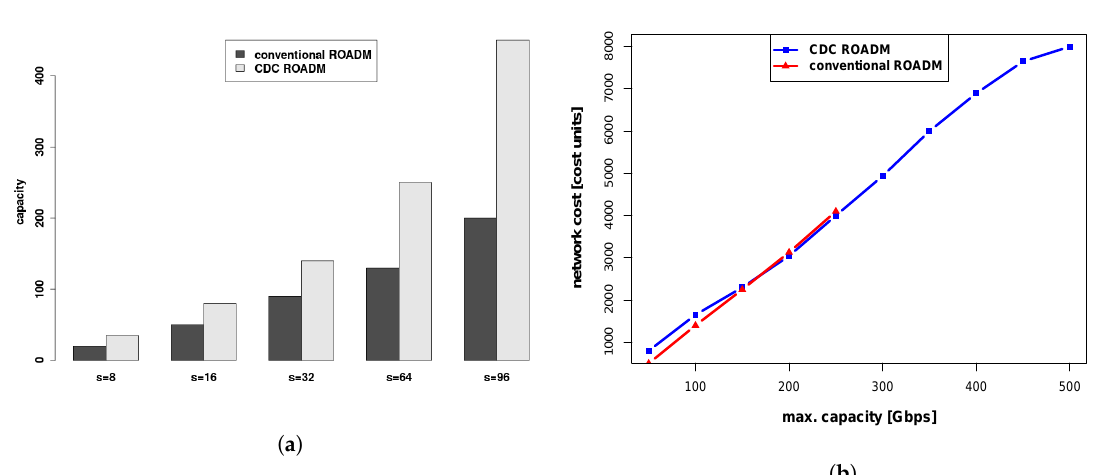
Figure 6. Dependence of maximum capacity of the network on the number of optical wavelength ( a ) and the dependence of network cost on maximum capacity of the network ( b ) for the German network.